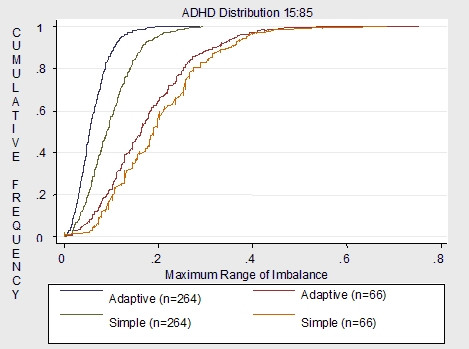
Non-stratifying factors: stratified simple vs. adaptive (5 covariates) for n = 66 and n = 264.